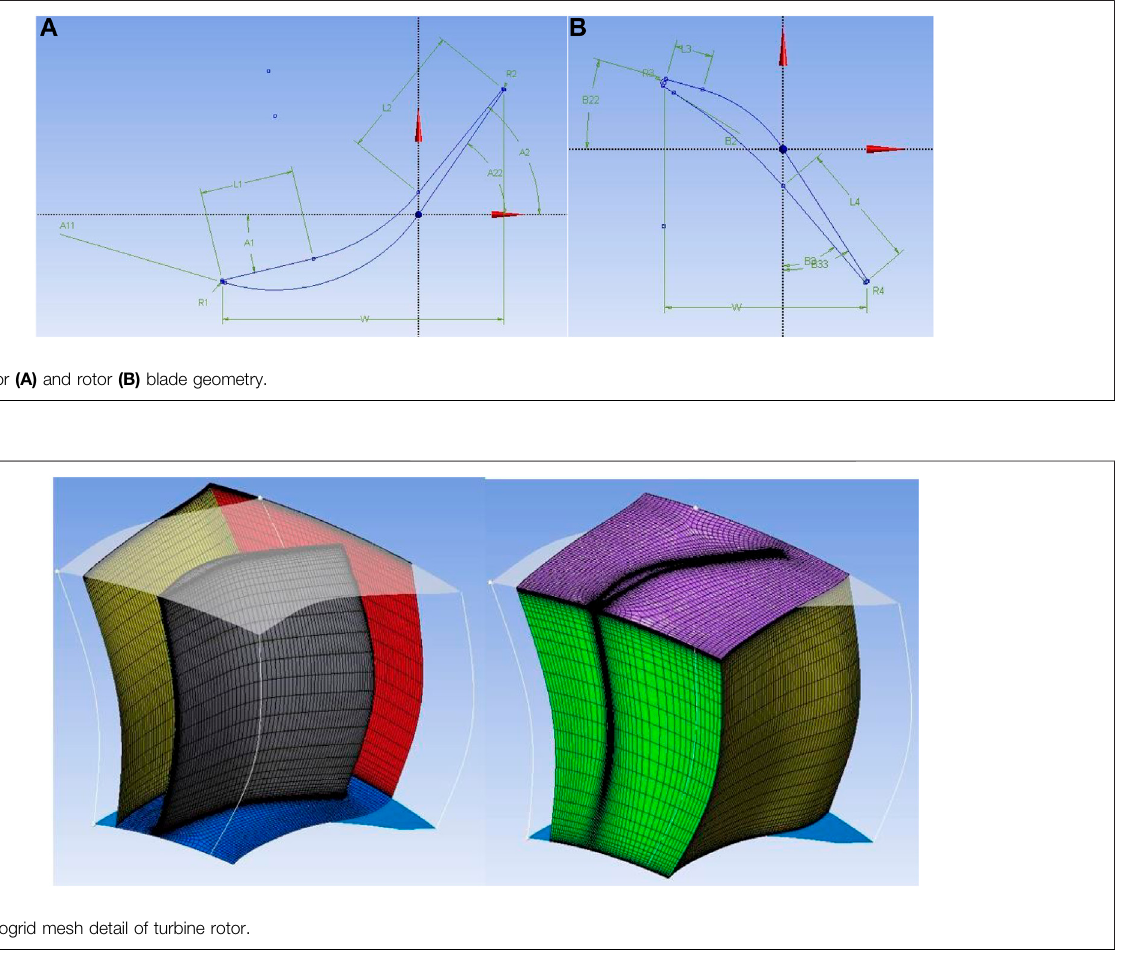
FIGURE 8 | Turbogrid mesh detail of turbine rotor.